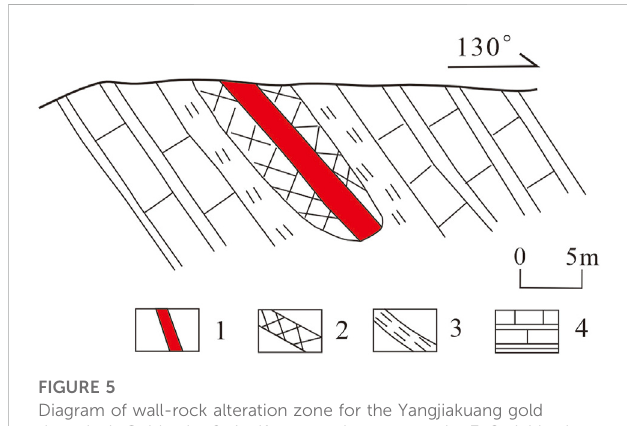
FIGURE 5 Diagram of wall-rock alteration zone for the Yangjiakuang gold deposit. 1. Gold vein; 2. Auriferous pyrite-quartz vein; 3. Sericitization zone; 4. Carbonation